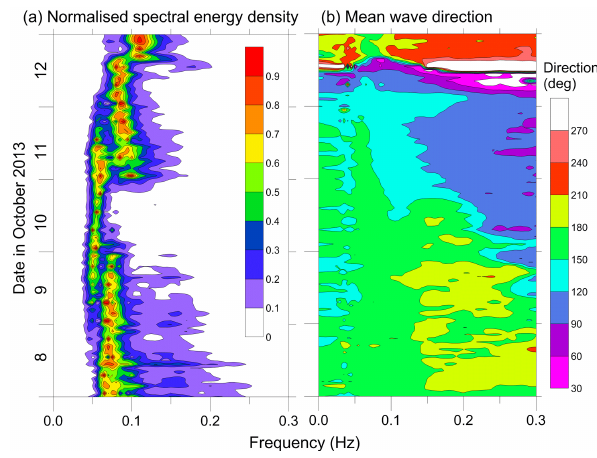
Figure 13. Time history of (a) normalised spectral energy density and (b) mean wave direction with frequency from 8 to 12 Octo- ber